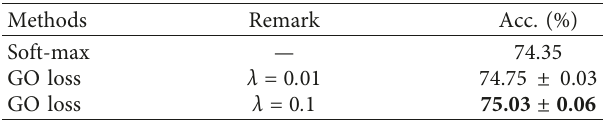
Table 7: Classification accuracy with ResNet-50 on CIFAR-100 dataset.